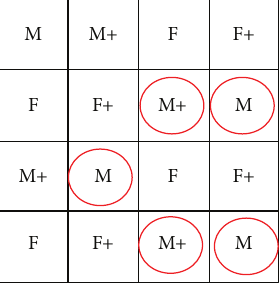
Figure 2: Population structure. Red circles indicate the possible mates of the female in the center of the neighborhood. Individuals with the plus sign are infected with Wolbachia